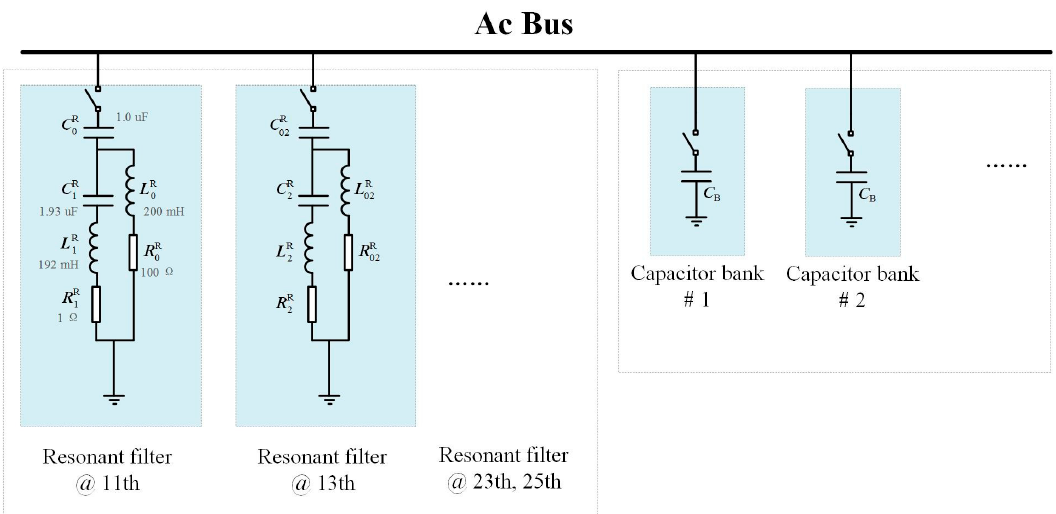
Figure 10. Resonant filter and capacitor structure.